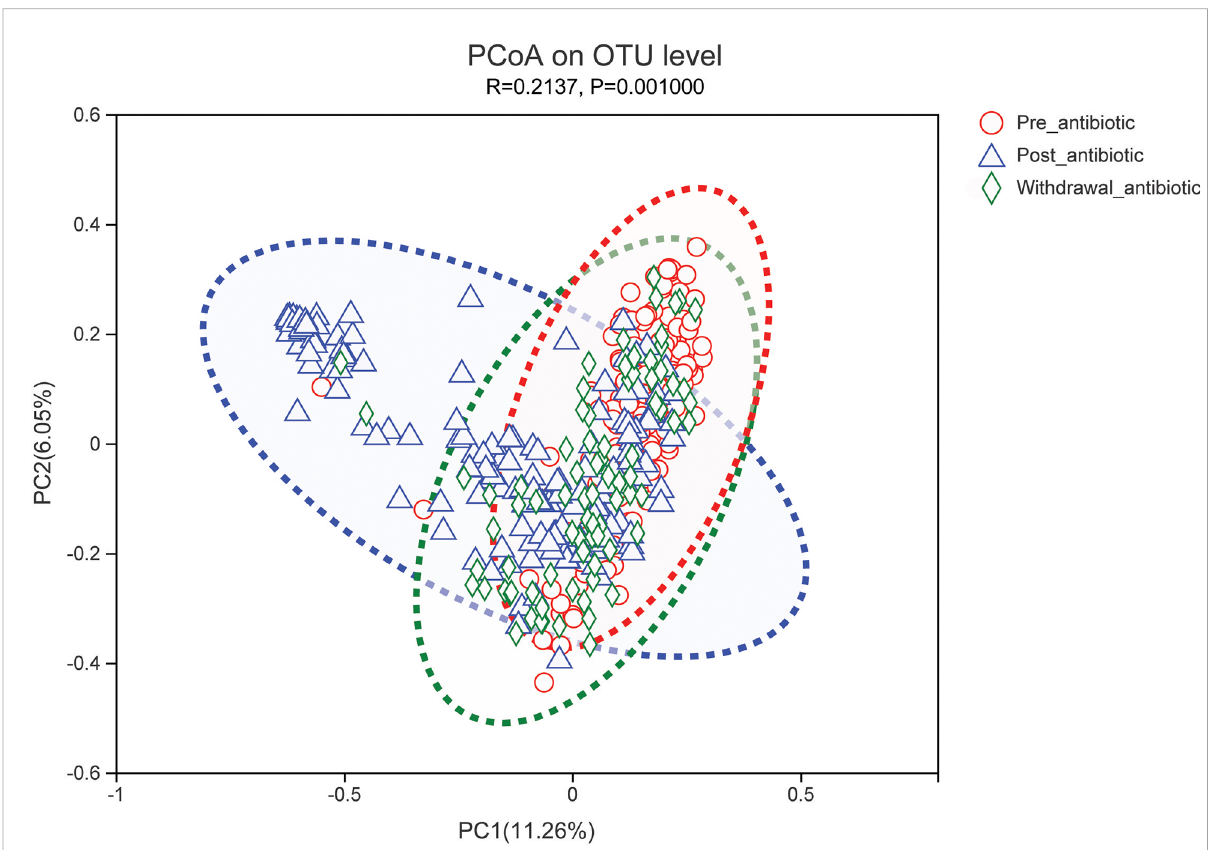
FIGURE 2 PCoA (principal coordinates analysis) of gut microbiota in each group for the antibiotics group. The dotted line represents the 95% con fi dence interval